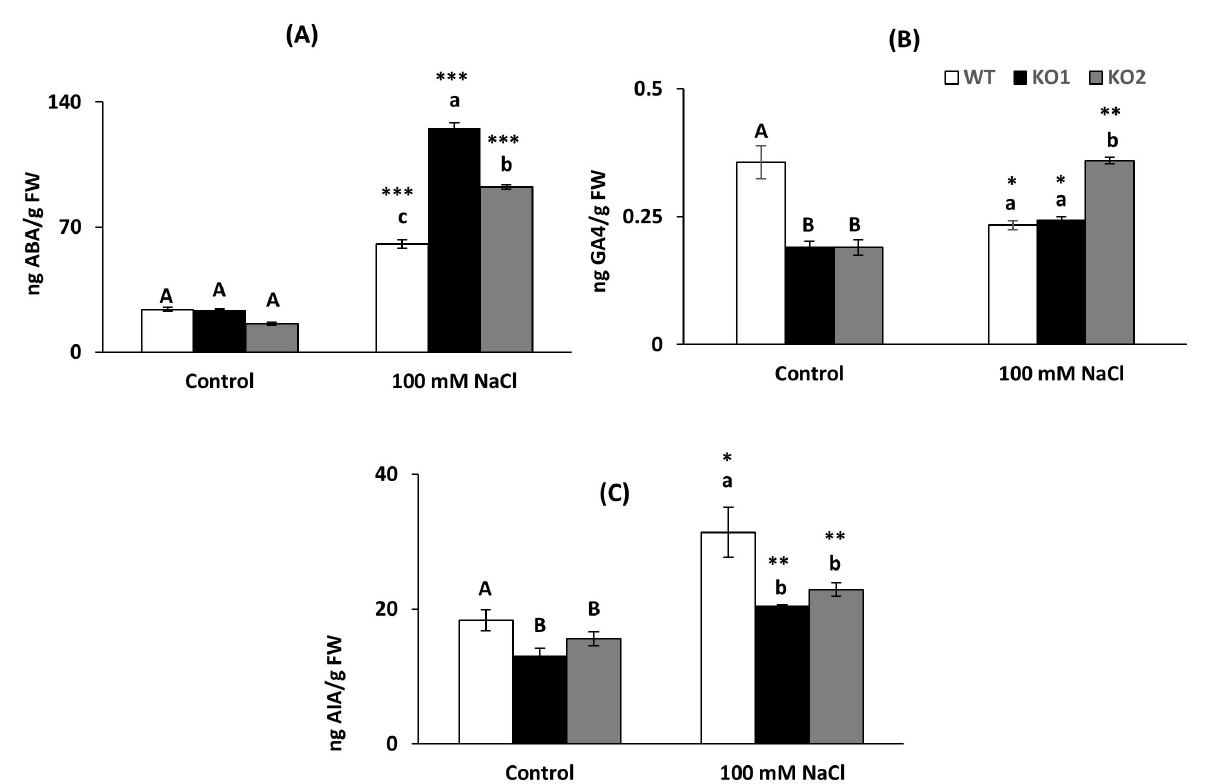
Figure 7. Hormone content in leaves of A. thaliana wild type (WT) and two KO Attrxo1 mutant lines grown in the absence (Control) and presence of 100 mM of NaCl. ( A ) Abscisic acid ABA, ( B ) gibberellin GA4 and ( C ) indoleacetic acid IAA are expressed by fresh weight (FW). Data are the mean ± SE of at least three independent experiments. Different letters indicate significant differences ( p < 0.05) among genotypes in each condition according to the Tukey’s test, and the asterisks indicate significant differences of each genotype in salinity compared to the control condition using the t -Student’s test (*, **, *** at p < 0.05, p < 0.01 and p < 0.001,